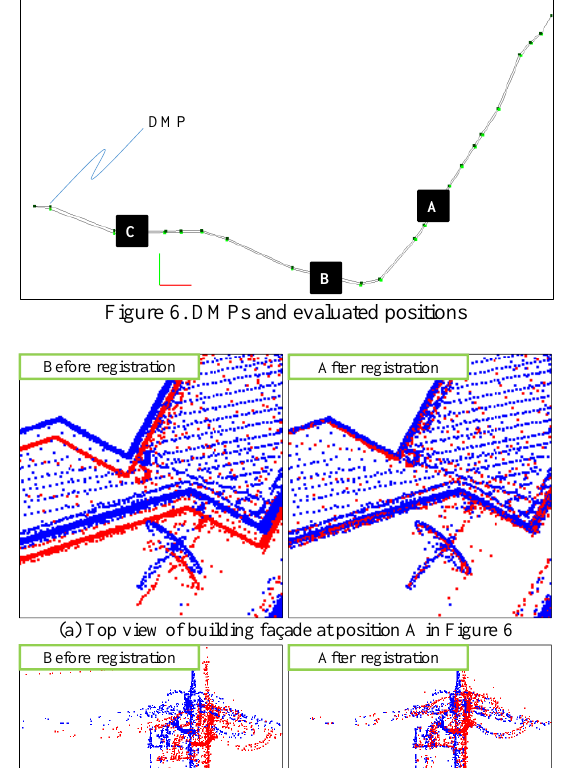
(a) Top view of building façade at position A in Figure 6